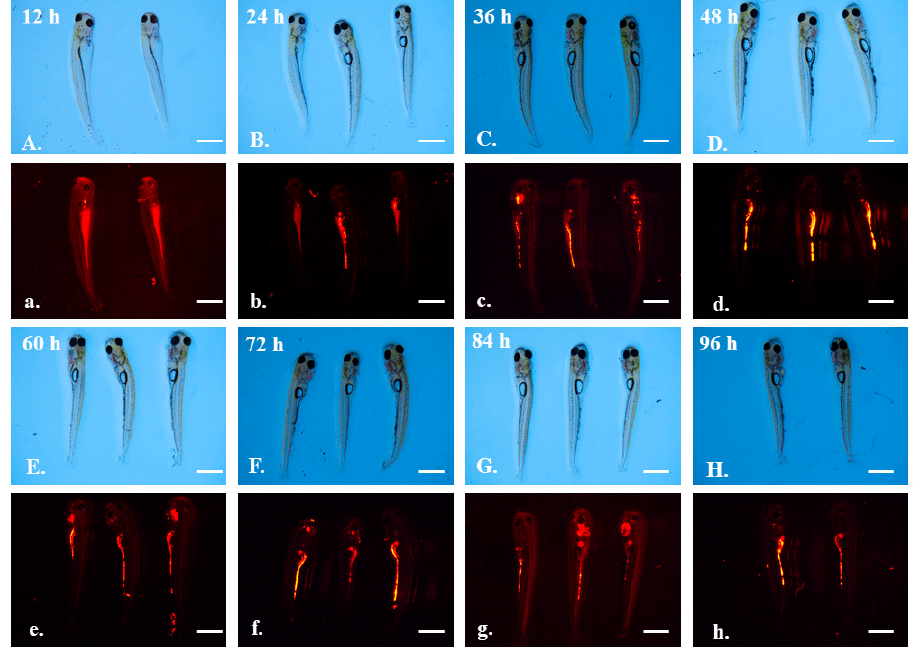
Figure 5. The larvae of grass carp after exposure to 5 μ m red fluorescent microplastics. Photographs were taken under a brightfield microscope (capital letters A – H ) and red fluorescent microscope (lowercase letters a – h ). Observation time was labeled in the figure. Scale bar = 2 mm.